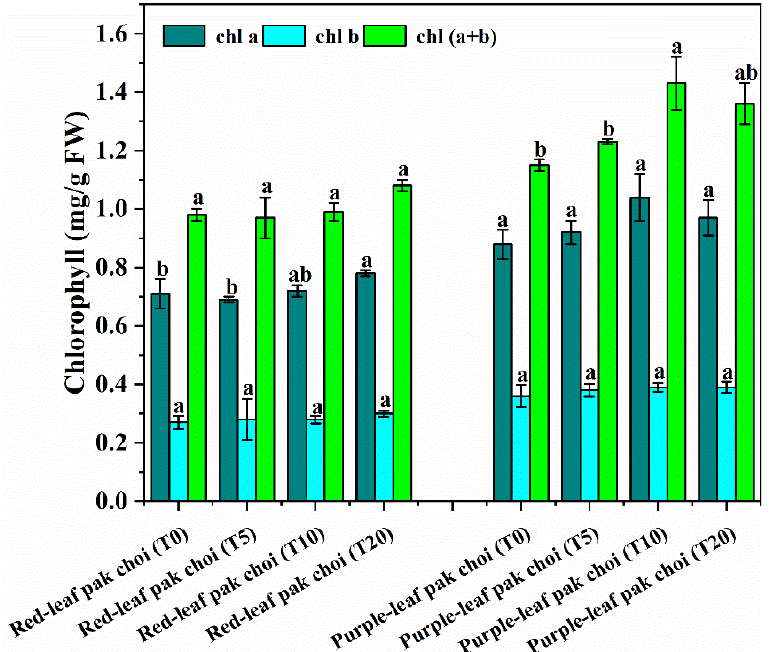
Figure 4. Effects on the chl a, chl b and total chl of red- and purple-leaf pak choi under blue and UVA light. T0, T5, T10 and T20 mean 0 UVA with 50 B, 5 UVA with 45 B, 10 UVA with 40 B and 20 UVA with 30 B (μmol·m − 2 ·s − 1 ), respectively. Different letters mean statistical differences determined with Duncan’s multiple test at p < 0.05 among treatments. Error bars indicate ± SE ( n = 3). Soluble sugar and soluble protein are another two important nutritional